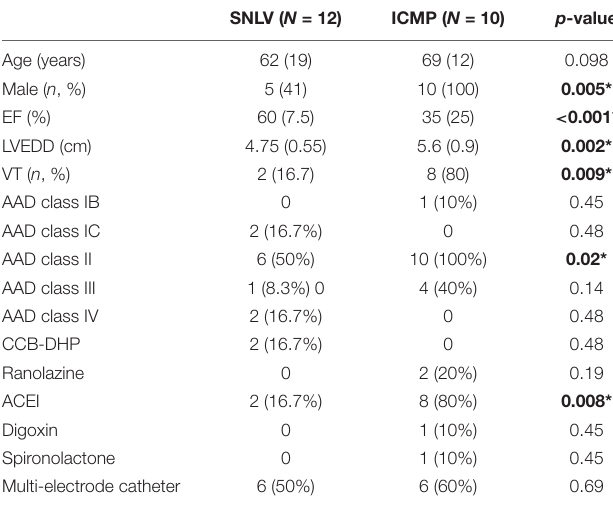
TABLE 1 | Baseline characteristics of patients with ICMP and